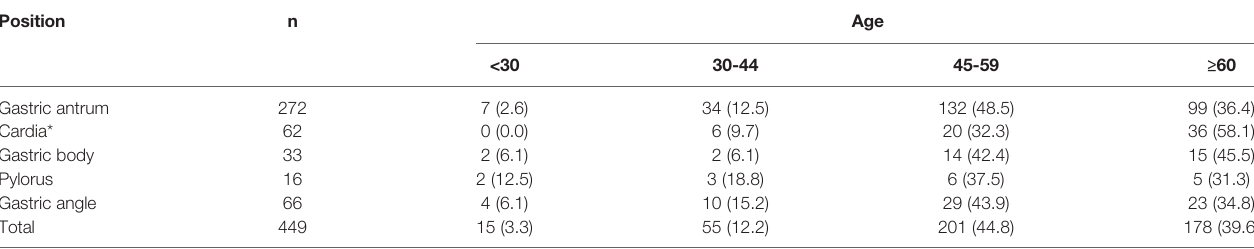
TABLE 2 | Association between lesion position and age of patients with low gastric intraepithelial neoplasia. Position n